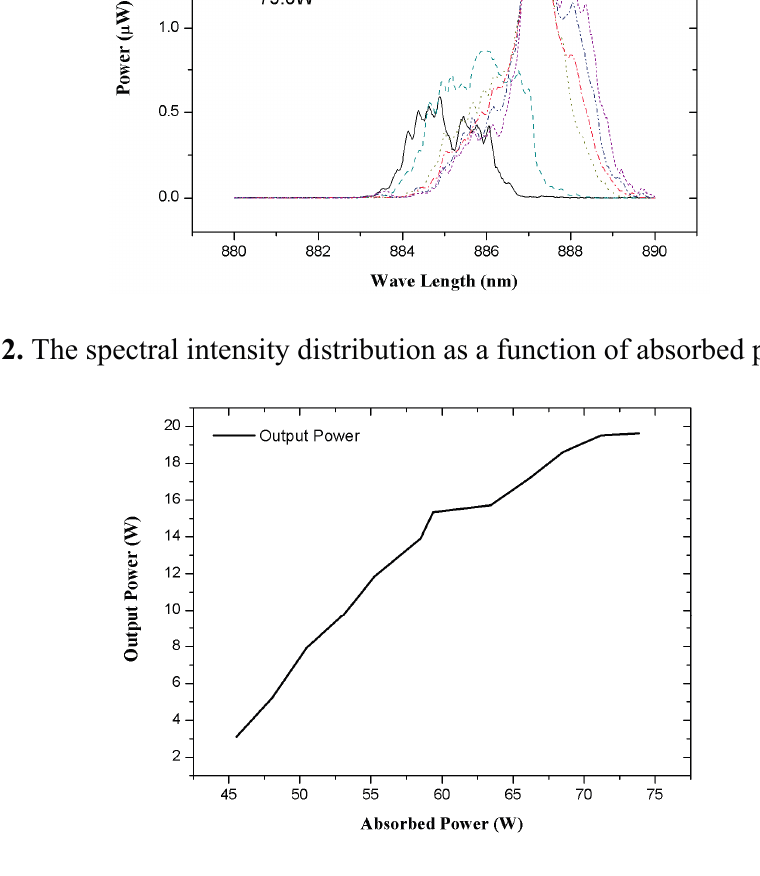
Figure 3. The output power as a function of absorbed power in operation.